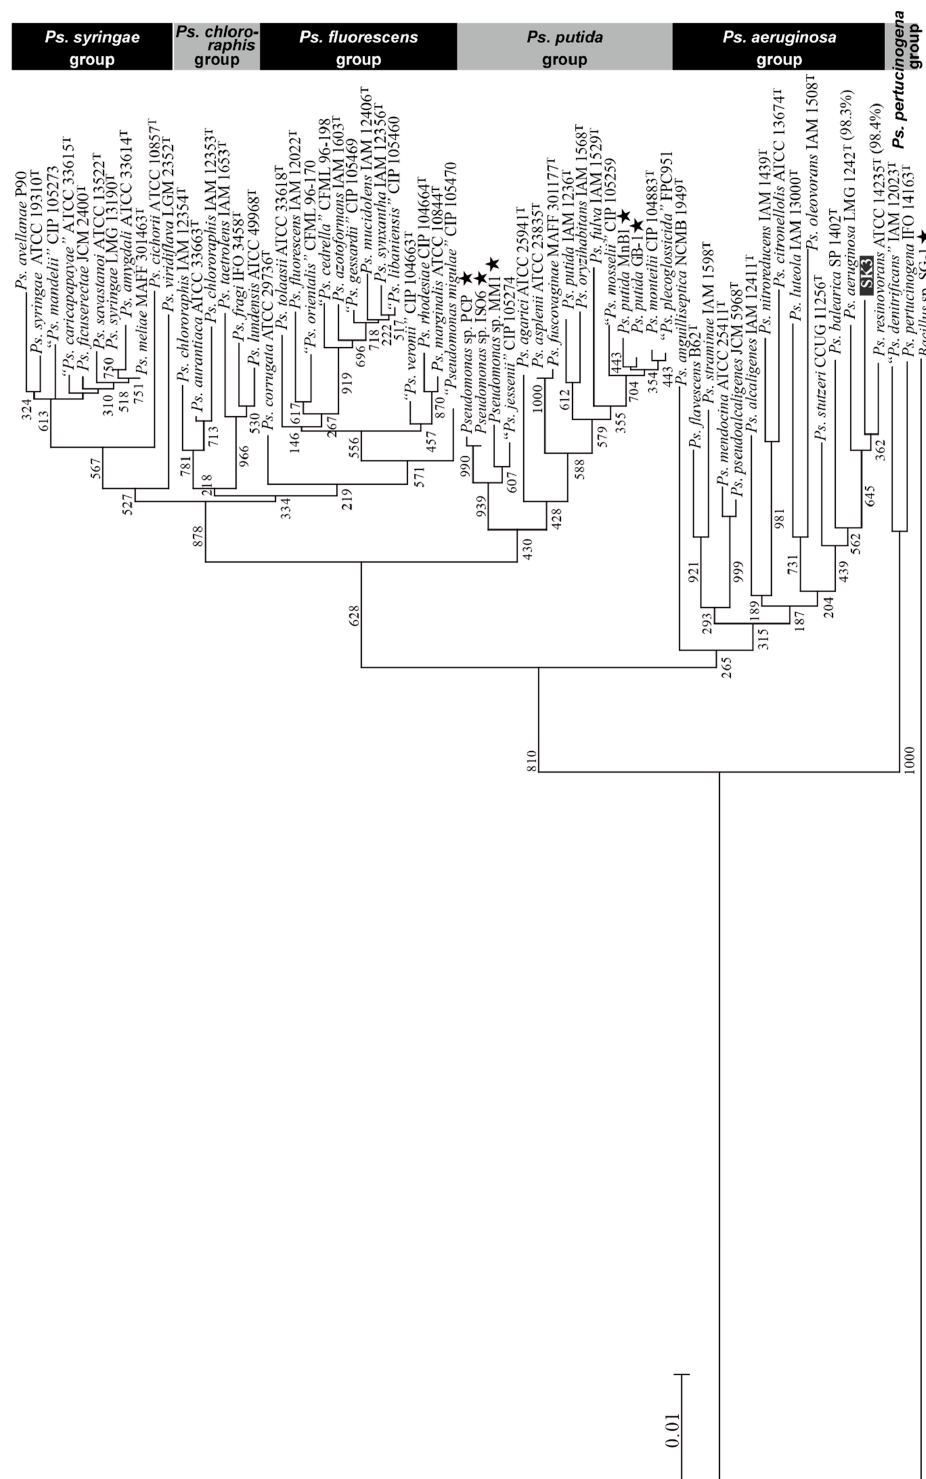
Figure 4. Phylogenetic tree of isolate SK3 in relation to known Pseudomonas spp., based on the 16S rRNA gene sequence, constructed by the neighbor-joining method (using Bacillus sp. SG1 as the outgroup). Known Mn(II)-oxidizing strains are marked ( (cid:70) ). Scale bar indicates the number of nucleotide substitutions per site. Numbers at nodes indicate bootstrap values for 1000 replicates of the original dataset. NCBI accession numbers are summarized separately in Table S1. Numbers in brackets indicate the 16S rRNA gene sequence identities with isolate